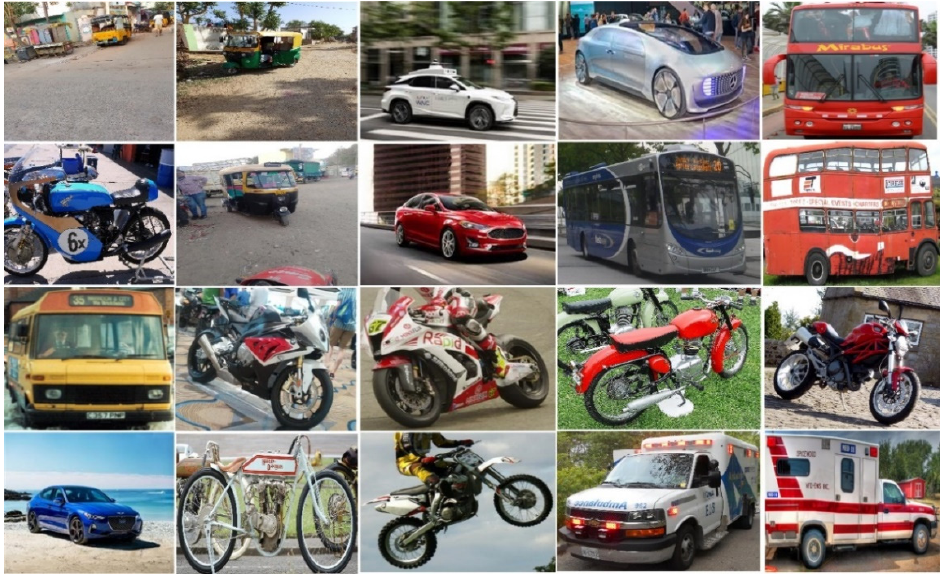
Figure 6. Various samples for training.